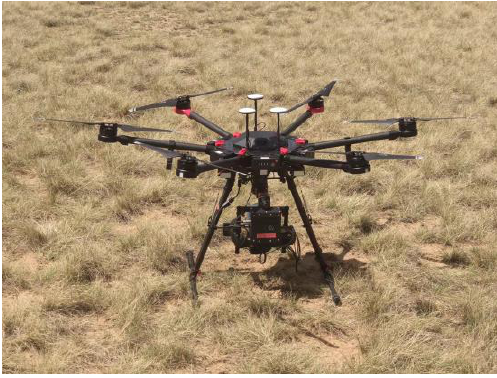
Figure 1. UAV hyperspectral remote sensing